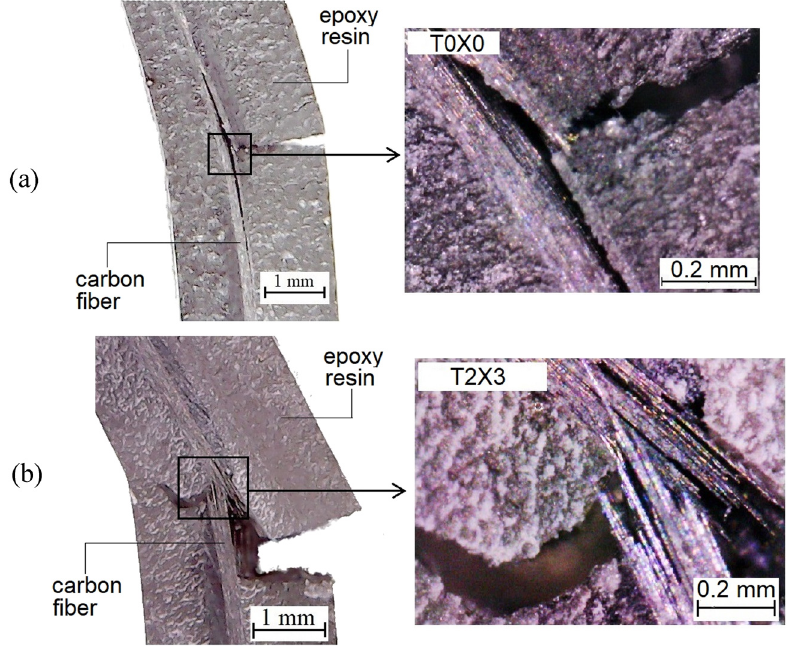
Figure 8: Macroscopic images of fracture pattern of ( a ) T0X0 and ( b ) T2X3